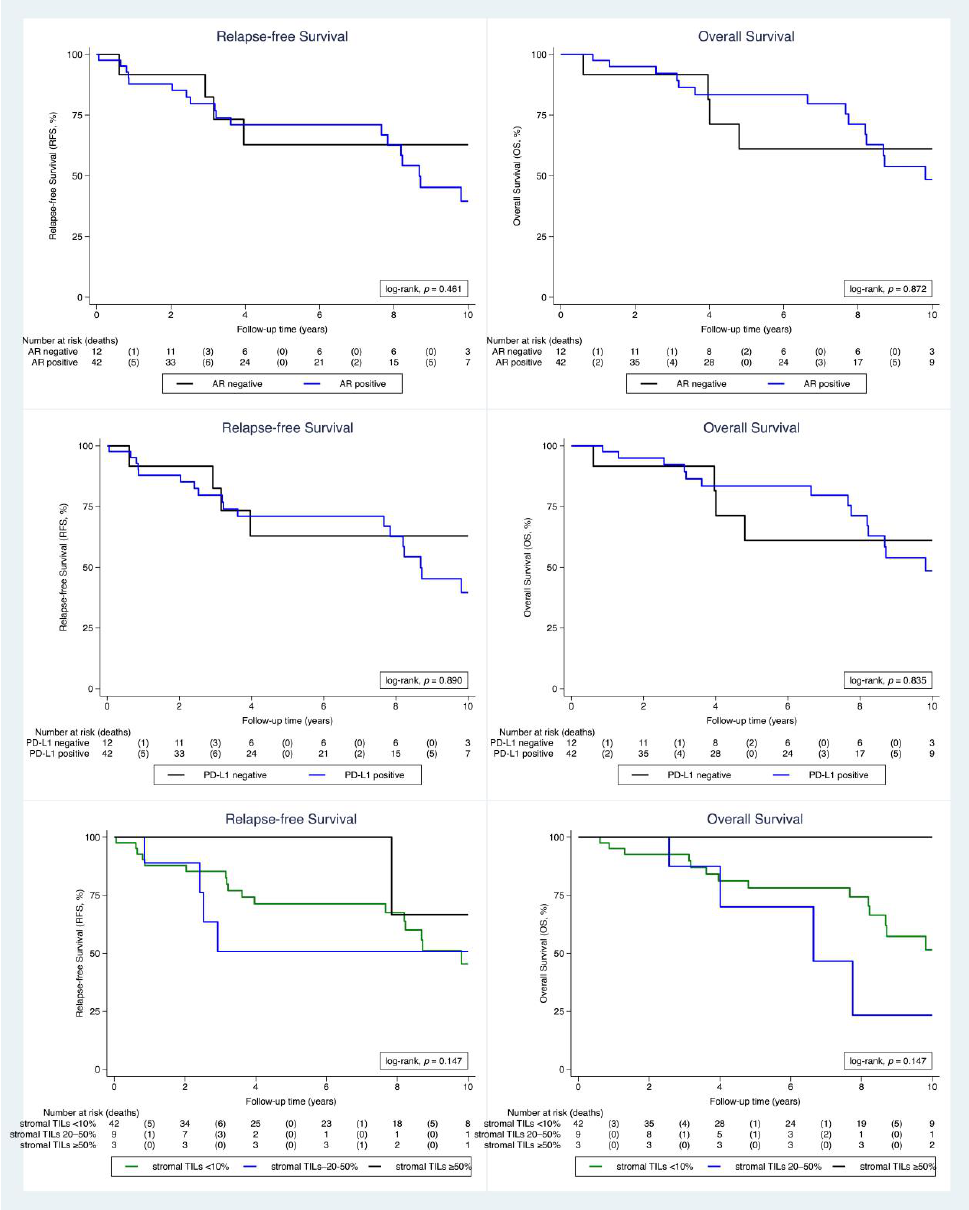
Figure 4. Relapse-free survival ( left panel ) and overall survival ( right panel ) according to AR, PD-L1 and stromal TILs expression in the cohort of 54 patients without distant metastasis at the time of diagnosis with available follow-up data.